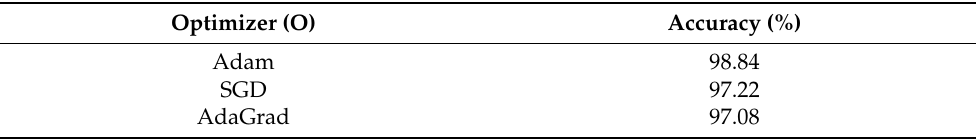
Table 8. Traffic sign recognition accuracy (%) with different optimizers (B = 64, L = 0.001). Optimizer